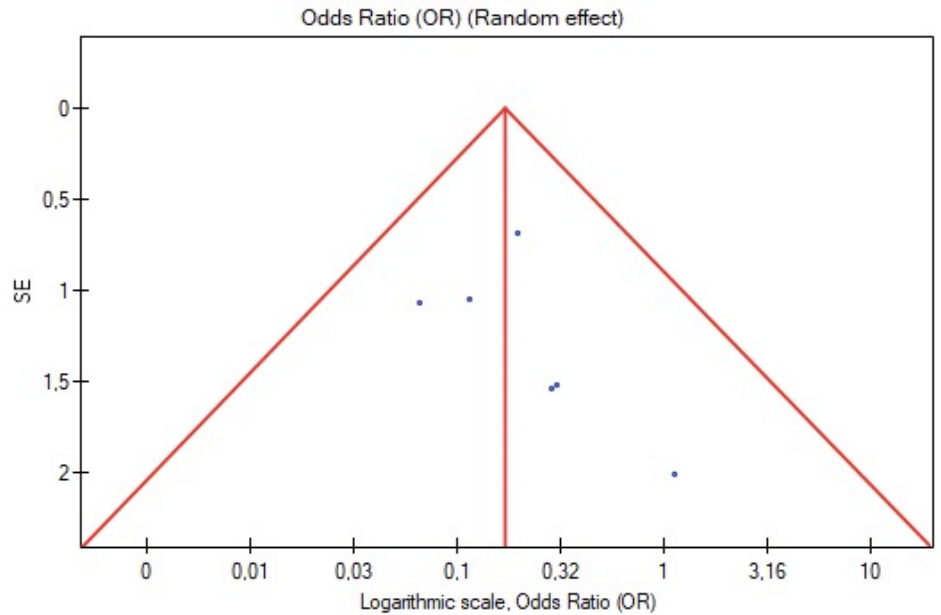
Figure 9. Funnel plot for secondary reinterventions.